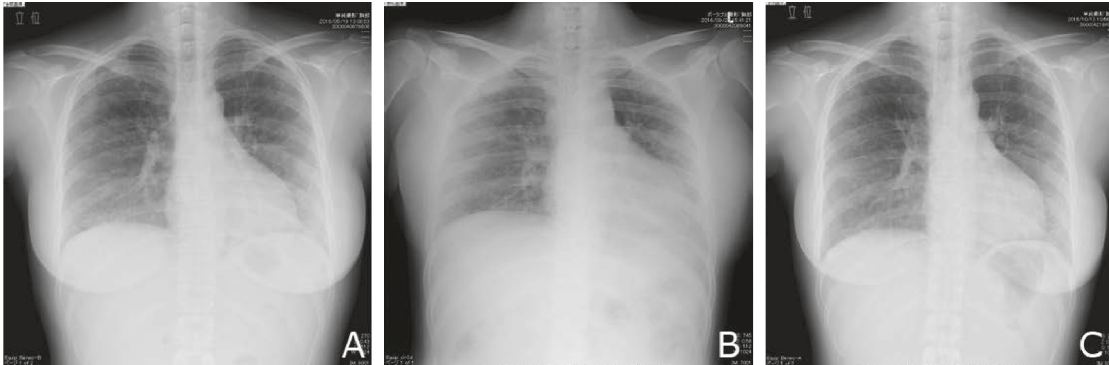
Figure 1: (a) Chest radiography on admission showing bilateral ground-glass opacity, (b) discharge radiography showing improvement of ground-glass opacity, and (c) postpartum radiography showing more improvement.